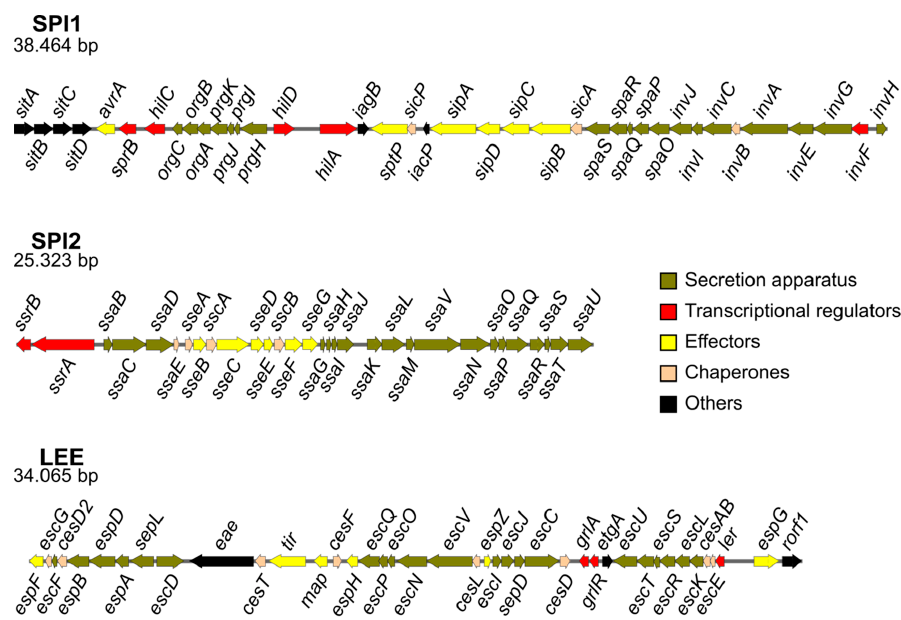
Figure 1. Genetic structure of Salmonella pathogenicity island 1 (SPI1) and Salmonella pathogenicity island 2 (SPI2) of S. enterica serovar Typhimurium strain 14028, and the locus of enterocyte effacement (LEE) island of E. coli O127:H6 strain E2348/69. Genes are colored according to their functional categories [22,28].